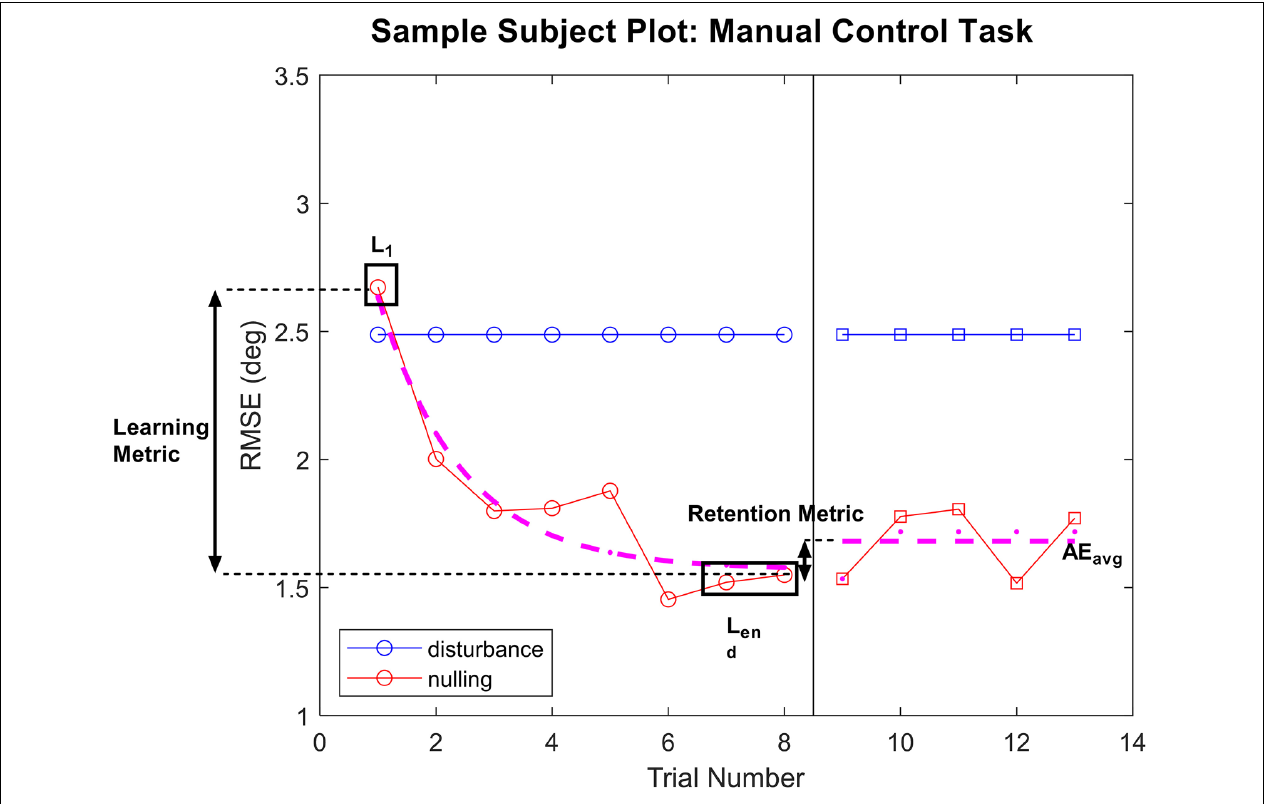
FIGURE 2 | Sample plot of performance for a subject in the manual control task. For both tasks, performance on each trial was plotted for the learning phase and the aftereffects phase. An exponential decay was fit to the learning phase, with L 1 and L end values pulled from the model fits with R 2 > 0.45. For subject whose learning was not well captured by the model fit ( R 2 < 0.45), raw performance on trials 1 or the average of trials 7 and 8 were used for L 1 and L end , respectively. Average performance across the aftereffects phase was used as AE avg in calculating the retention